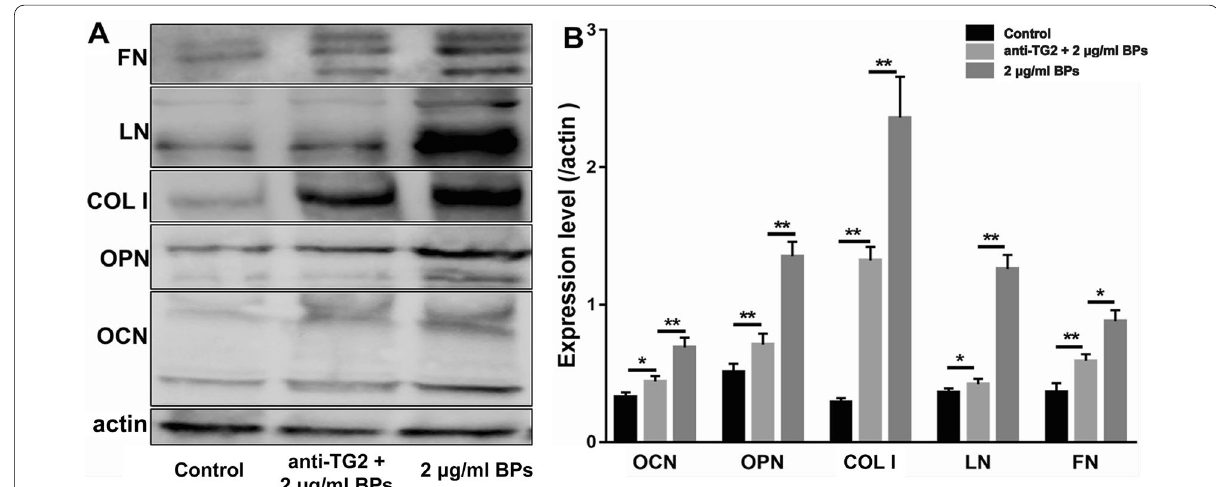
Fig. 9 Anti-TG2 inhibited BP-induced EMSC osteogenic differentiation. A Representative western blots of osteoponin, osteocalcin, and collagen 1 (OPN, OCN, LN, FN, and COL I, respectively) in differentiated EMSCs following treatment with 2 μg/ml BPs and 2 μg/ml anti-TG2 or 2 μg/ml BPs alone. B Quantification of OPN, OCN, and COL I protein expression. Data were expressed as mean